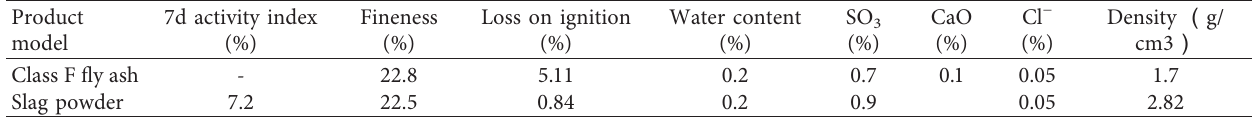
Table 2: Fly ash and mineral powder indicators.